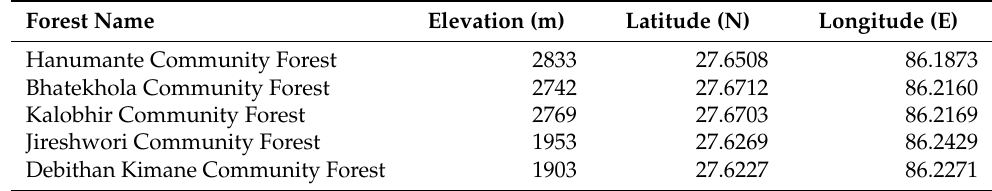
Table 1. Location and elevation (m) of community forests from where samples were collected. Forest Name Elevation (m) Latitude (N) Longitude (E)